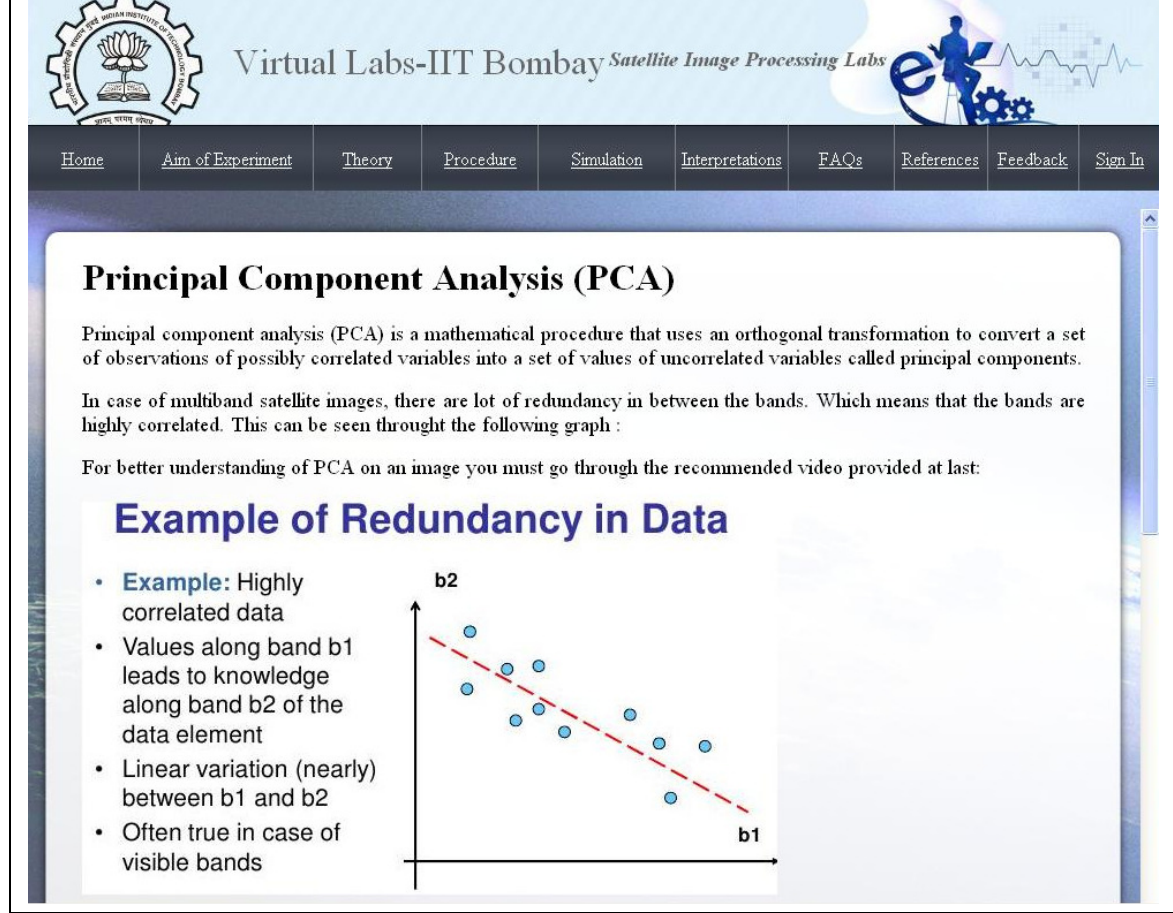
Figure 2. Example of theoretical principles for the Principal Component Analysis